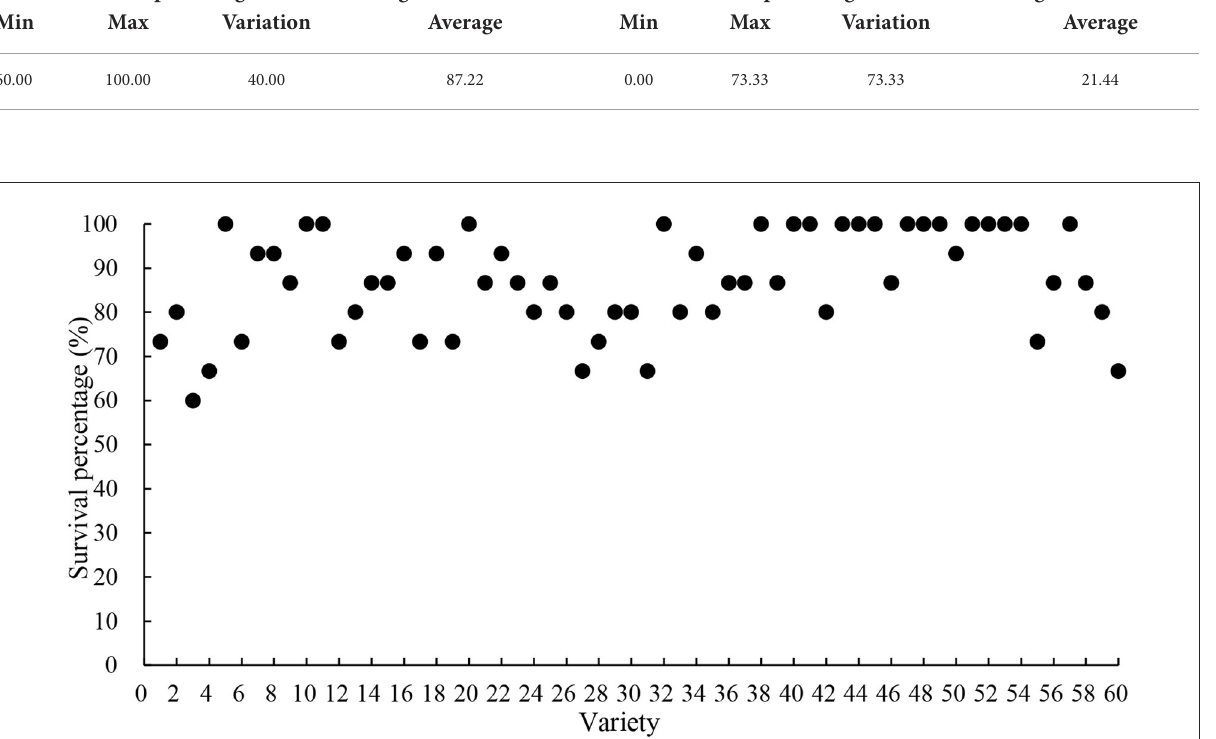
Table 4 showed that the correlation coefficients between the average survival rate of drought stress and the survival rate of the first drought stress and the second drought stress were 0.875 and 0.943, respectively, which reached a very significant level. The correlation coefficient between the survival rate of the second drought stress and the survival rate of the first drought stress is higher than that of the first drought